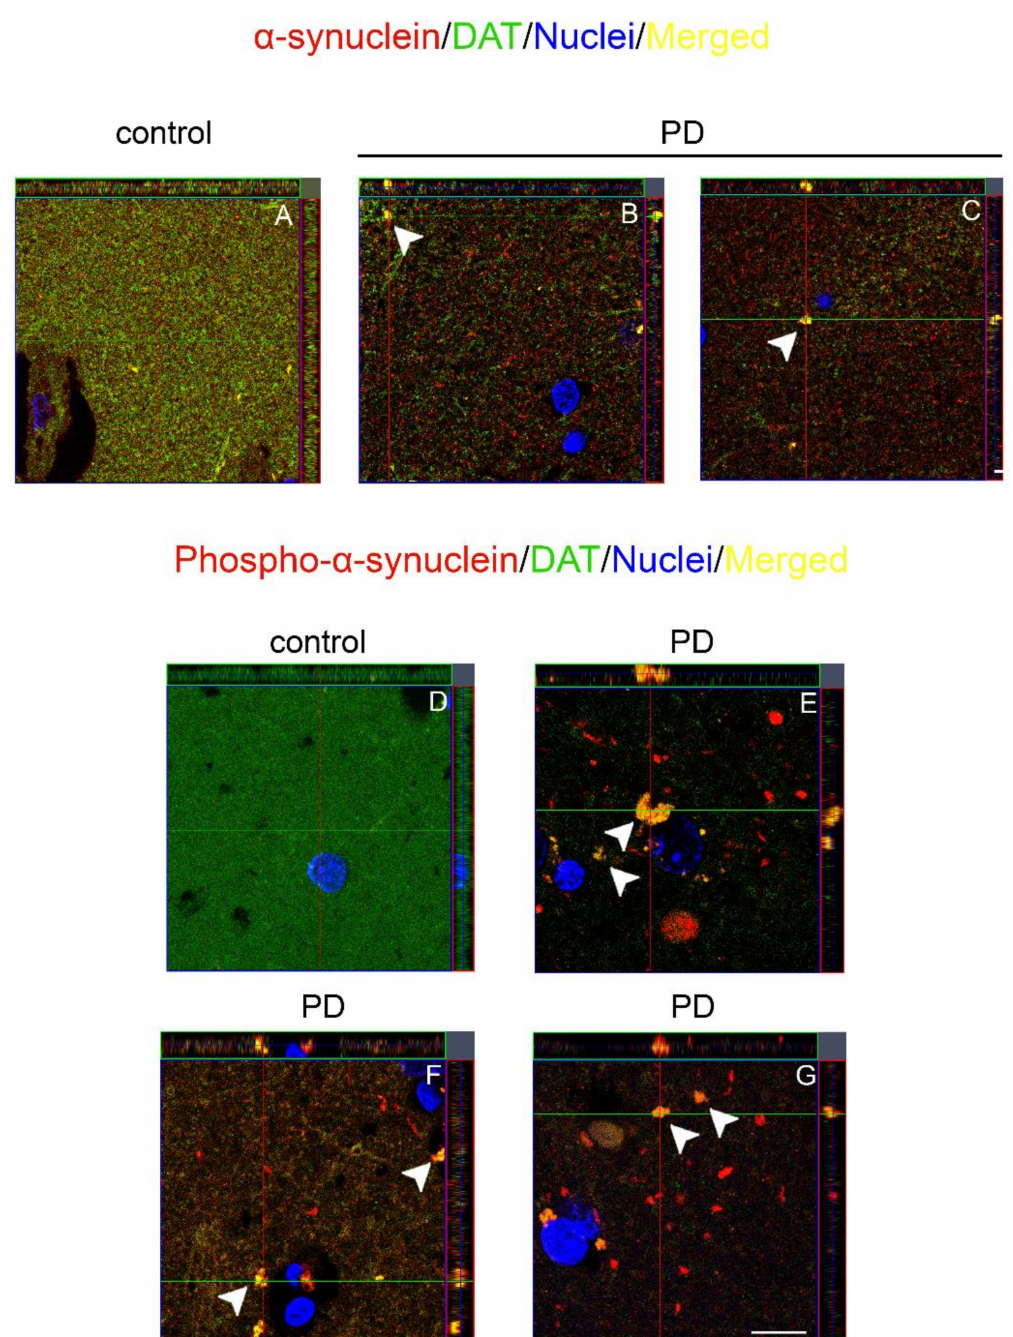
Figure 3. Orthogonal z reconstruction of α -synuclein/DAT and phosphor- α -synuclein/DAT immunolabeling. ( A – C ) Representative images of orthogonal z reconstruction of α -synuclein (red) and DAT (green) immunolabeling performed in the control subjects ( A ) and PD patients ( B , C ). Please note the presence of clumps that showed immunopositivity for both signals ( B , C , arrowheads) in the caudate putamen of the brain of patients affected by PD; ( D – G ) Panels are showing the orthogonal z reconstruction of phospho- α -synuclein (red) and DAT (green) staining. Please note the absence of phosphorylated form of α -synuclein in the brain of control subjects ( D ), whereas in the brain of patients affected by PD, we observed the presence of phospho- α -synuclein/DAT positive clumps ( E – G , arrowheads). Scale bars: ( A – C , D – G ) 20 µ